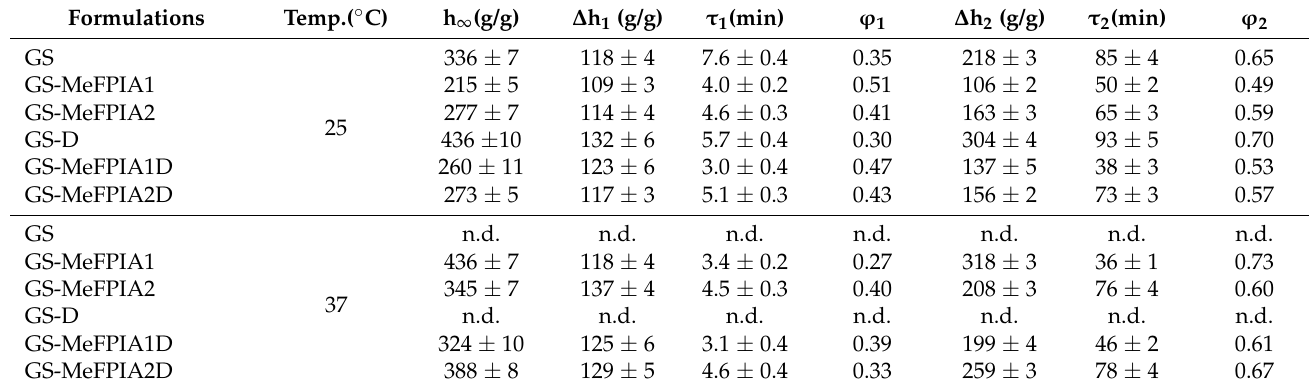
Table 5. Kinetic parameters of swelling for the different gelatin-based films. Temp. Formulations